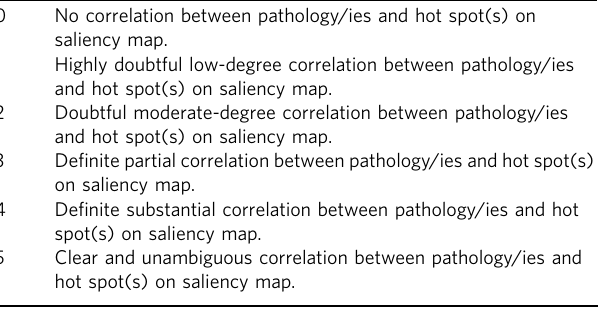
Table 2 Rating standard used for evaluating the diagnostic value of generated saliency maps.